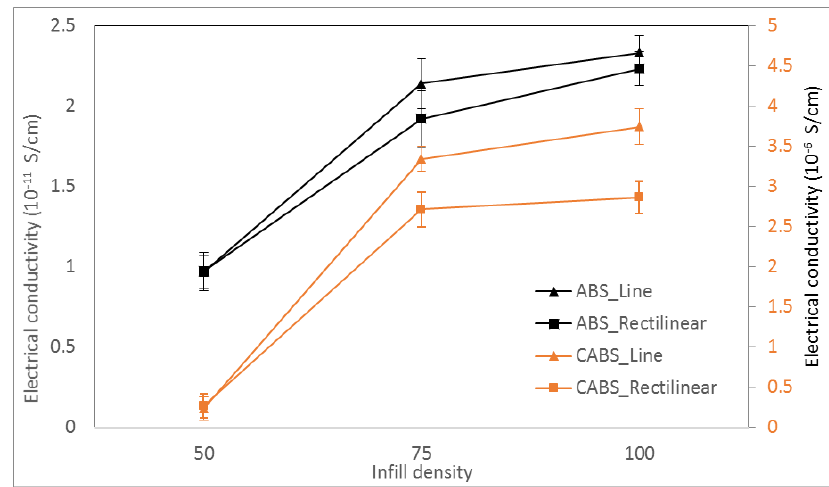
Figure 9. Electrical conductivity of ABS and CABS composites with different infill density and printing pattern.